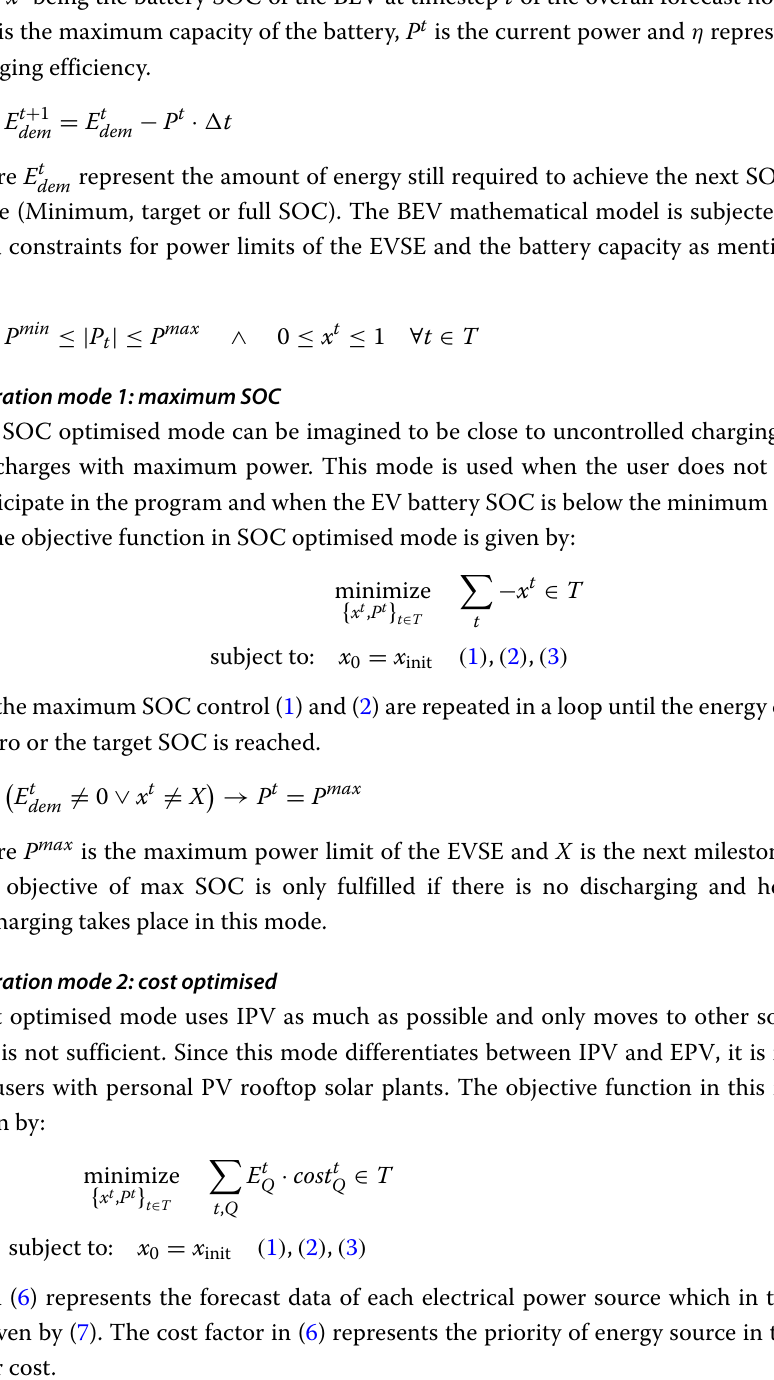
Mathematical model